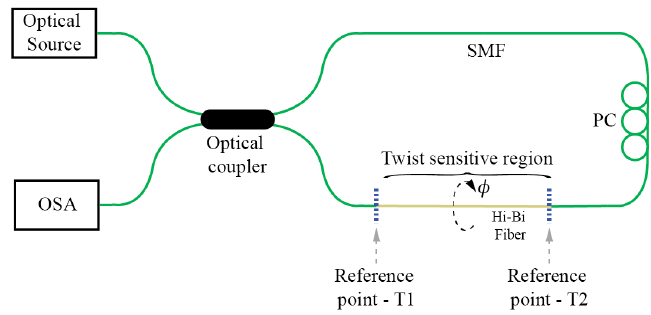
Figure 4. Twist/rotation sensor employing a Sagnac interferometer.